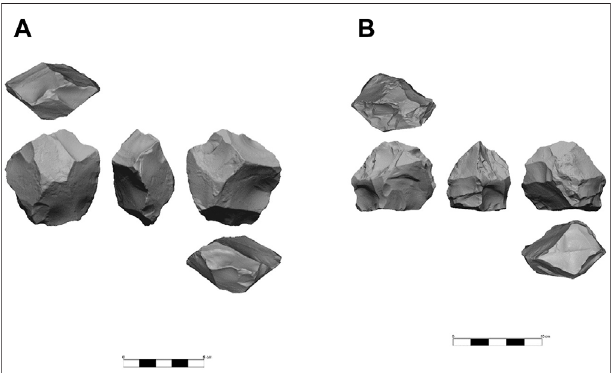
FIGURE 4 | Discoid alternate cores from